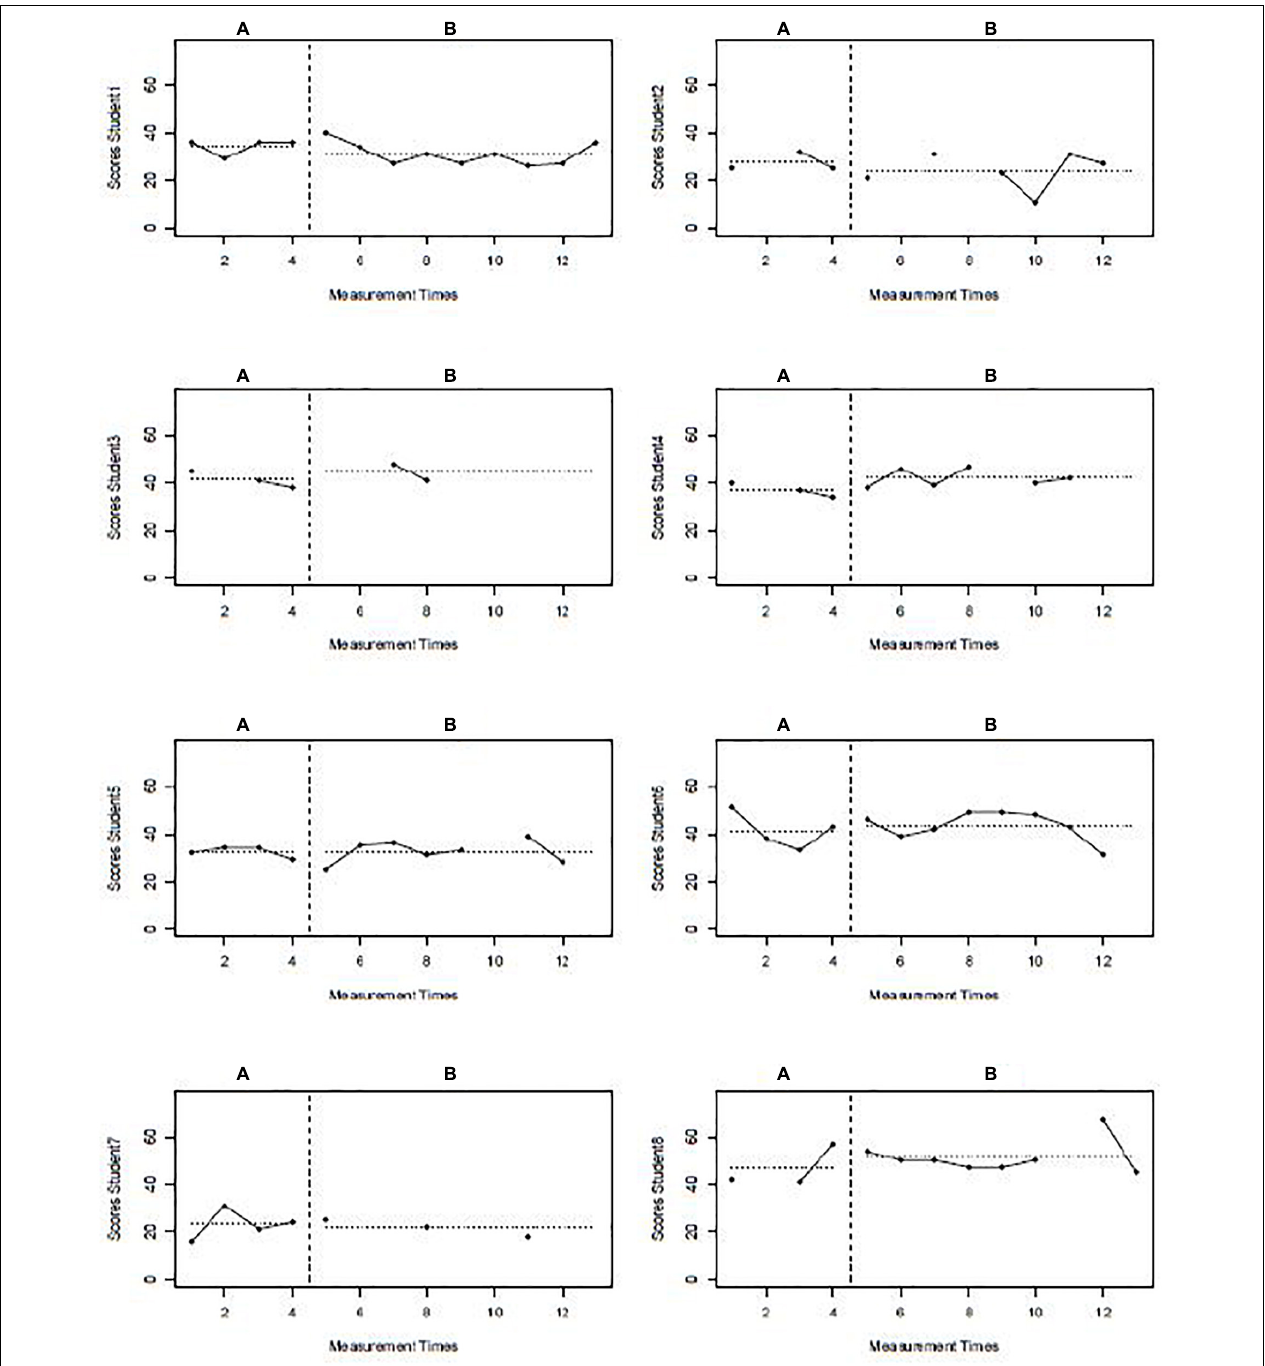
FIGURE 3 | Baseline (A) and intervention (B) phases for SRL total score for each participant ( n =